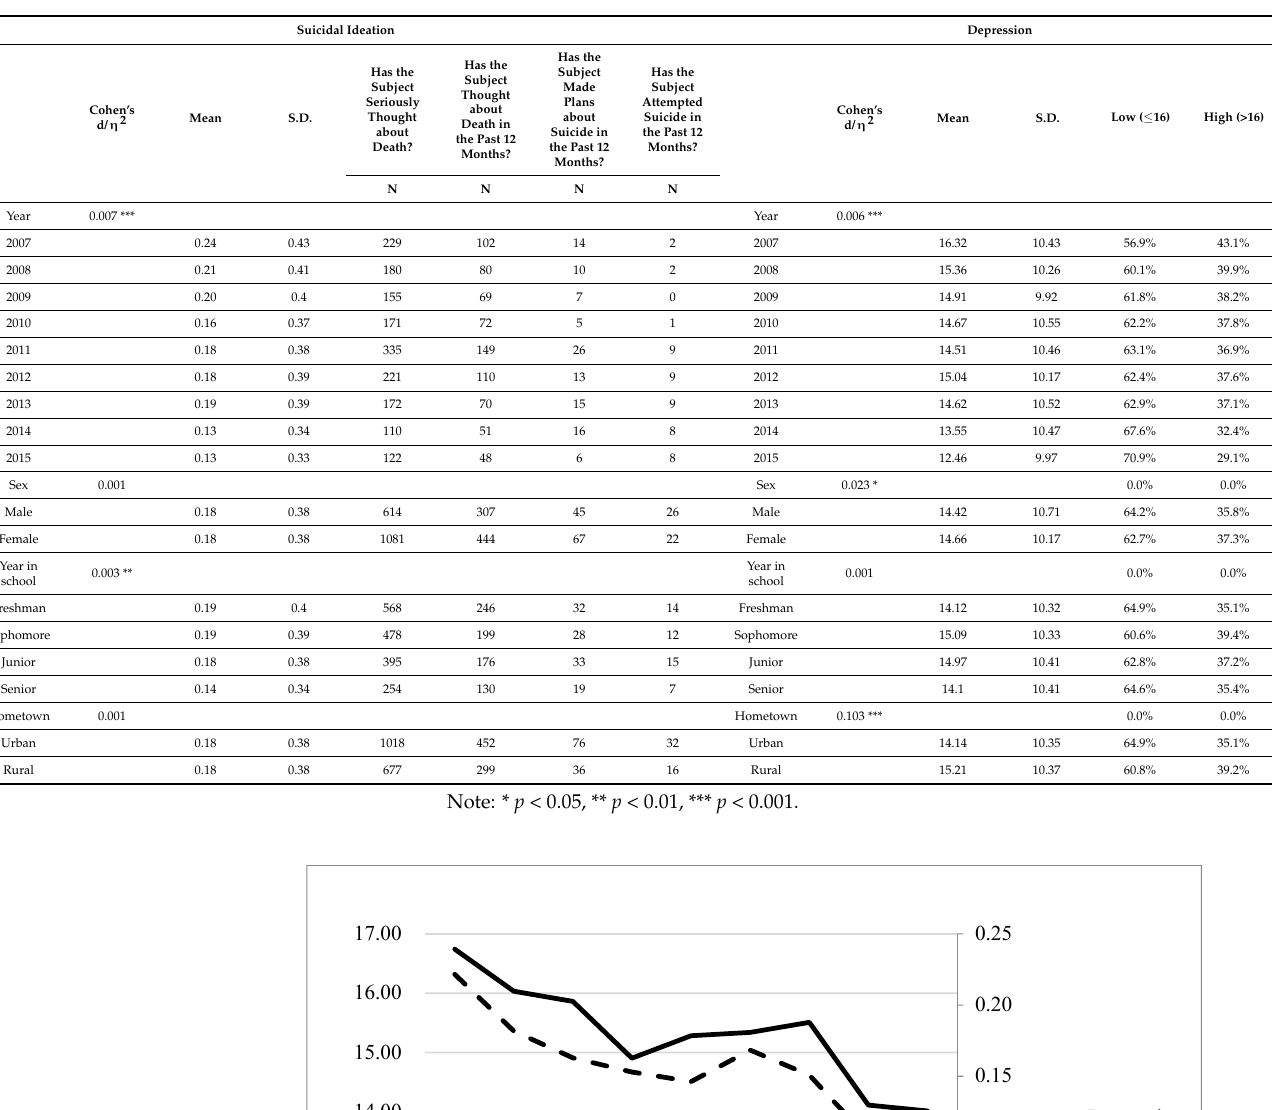
Table 3. Suicidal ideation and depression in college students from 2007 to 2015.